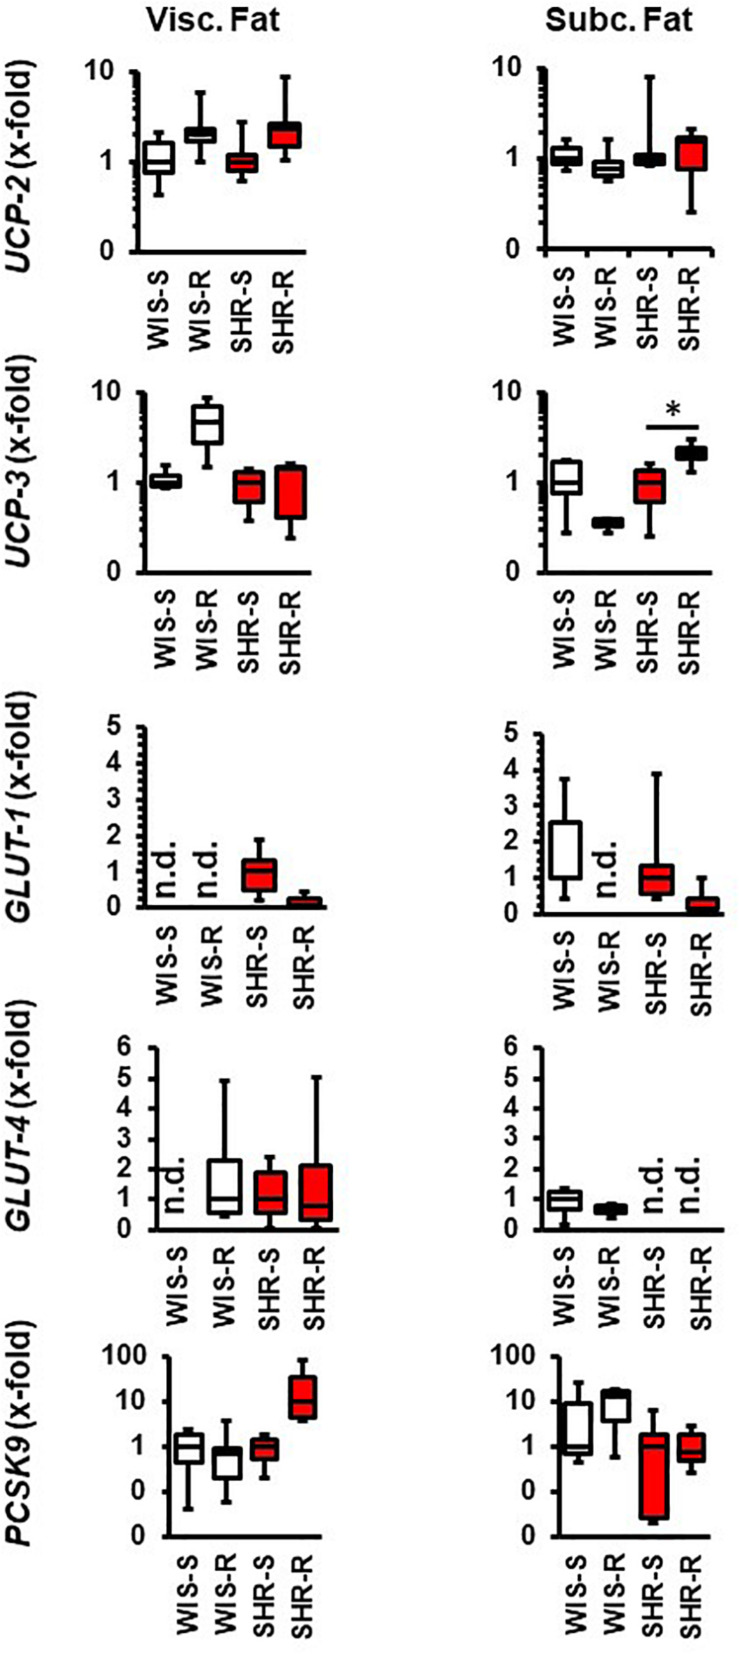
Effect of free running wheel activity (R) on mRNA expression in fat tissue and comparison between both strains. Sedentary controls (S) for each strain set as 1. Data are box plots representing the 25, 50, and 75% quartile and the whiskers representing the total range. Data represent the mRNA expression at the age of 11.5 months of exercise. n.d., not detectable. ∗p < 0.05 vs. sendentary (sed).